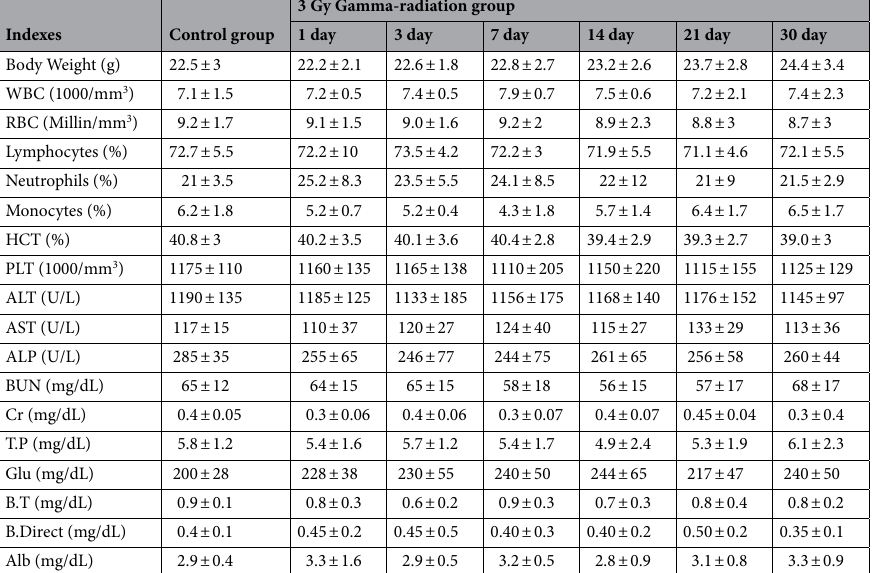
Table 1. The hematological and biochemical parameters in the effects of 3 Gy gamma radiation on 1, 3, 7, 14, 21, and 30 days post-radiation. Values are means ± SD. RBC = red blood cell, HCT = hematocrit, WBC = white blood cells, Plt = platelets, BUN = blood urea nitrogen, Cr = creatinine, Glu = glucose, AST = aspartate transaminase, ALT = alanine transaminase, ALP = alkaline phosphatase, Alb = albumin, T.P = total protein, B.T = Bilirubin Total, B.Direct = Bilirubin